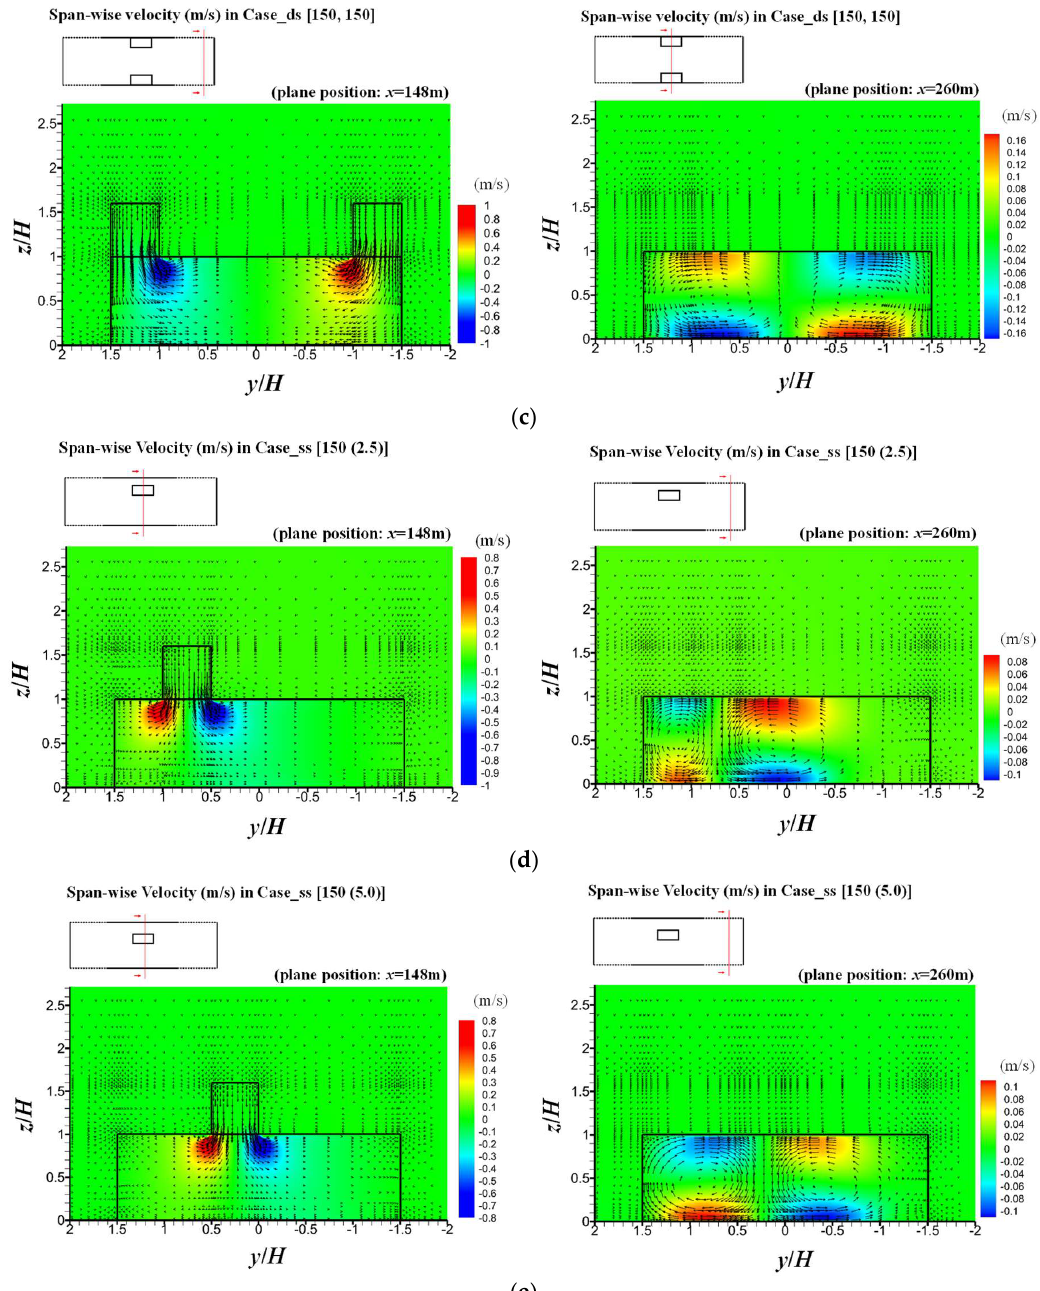
Figure 7. Span-wise velocity on a vertical cross section at x = 148 m ( x/L = 0.54) and x = 260 m ( x/L = 0.96) respectively. ( a ) Case_sl [150]; ( b ) Case_ss [150]; ( c ) Case_ds [150, 150]; ( d ) Case_ss [150 (2.5)]; ( e ) Case_ss [150 (5.0)]. (2.5)]; ( e ) Case_ss [150